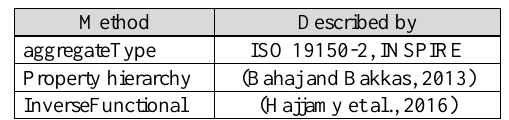
Table 6. Methods for transforming